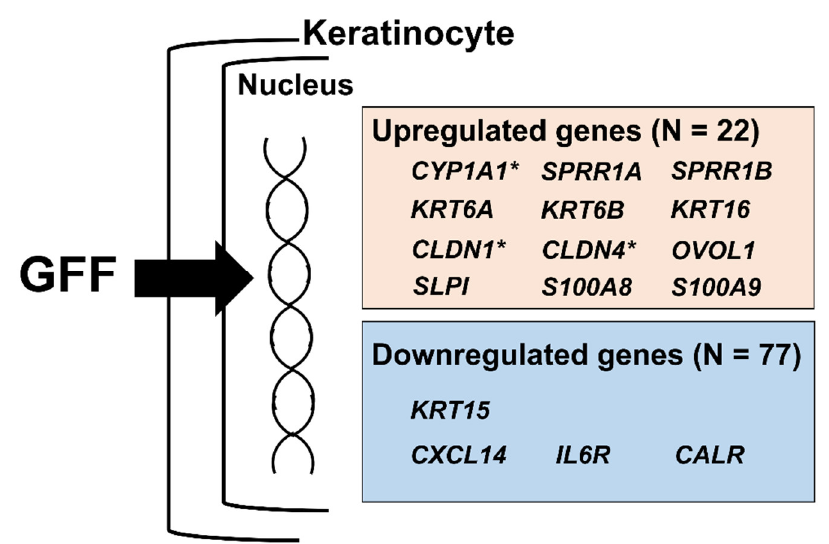
Figure 2. Representative genes with modified expression in GFF-treated keratinocytes. * Genes which were reported to be modified in GFF-treated keratinocytes. GFF: Galactomyces ferment filtrate.